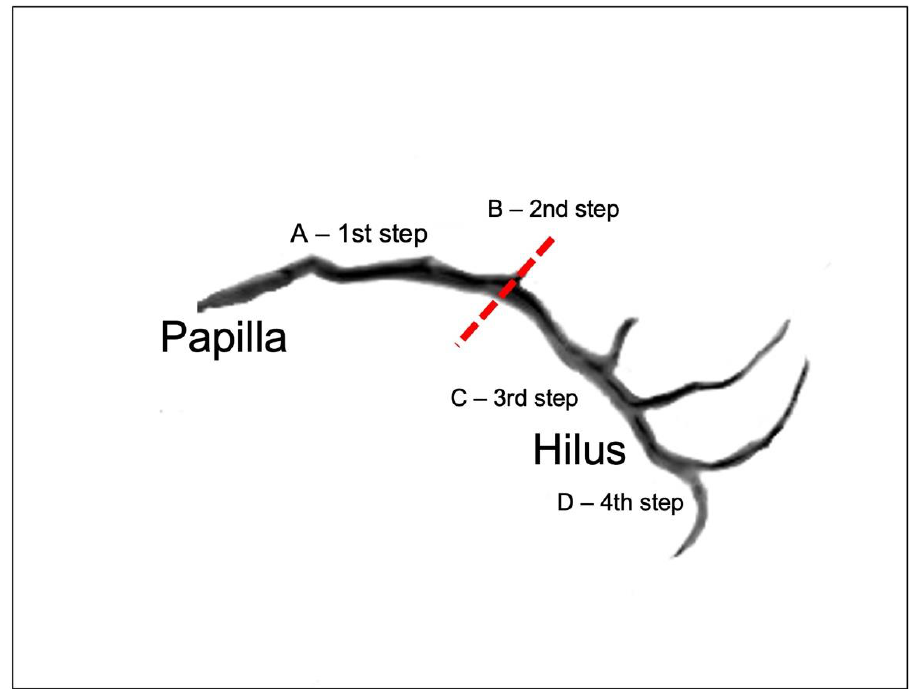
Figure 6. Steps of parotid duct endoscopy in relation to duct anatomy. Dotted red line — mid-point of curvature.